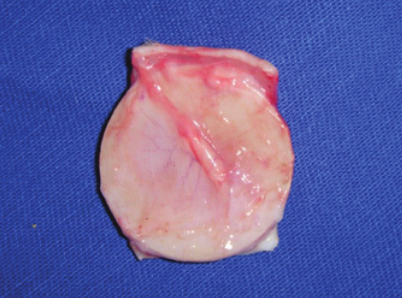
FIGURE 4 - Surgical specimen after withdrawal from surgical